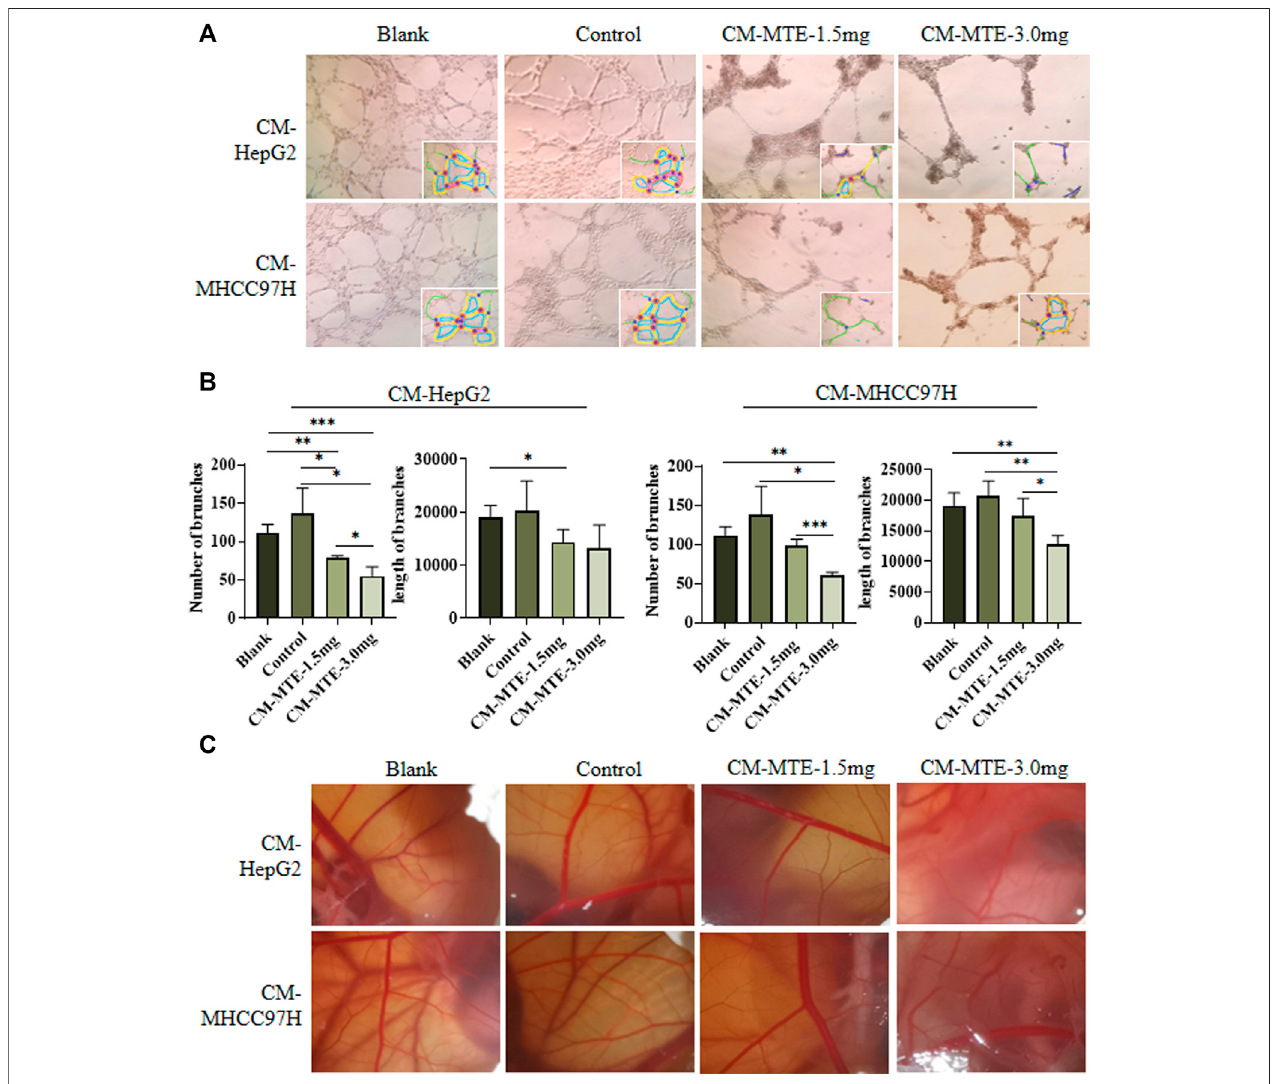
FIGURE 3 | MTE inhibited tumor angiogenesis by regulating the expression of pro-angiogenesis molecules in HCC cells. (A) Effect of conditioned medium (CM) from HCC cells treated withor withoutMTE on endothelium tube formationwas detected bytube formation assayofHUVECs. (B) Statistical analysis ofthe number and lengthofendotheliumtubebranchesindifferentgroups. (C) EffectofCMfromHCCcellstreatedwithorwithoutMTEonangiogenesiswasdetectedbychickCAMassay. Blank:DMEM;control:CM fromHepG2or MHCC97H cellswithout MTEtreatment;CM-MTE-1.5 mg: CMfrom HepG2orMHCC97Hcells treatedwith1.5 mg/ml MTE; CM-MTE-3.0 mg: CM from HepG2 or MHCC97H cells treated with 3.0 mg/ml MTE. * p < 0.05; ** p < 0.01; *** p < 0.001.